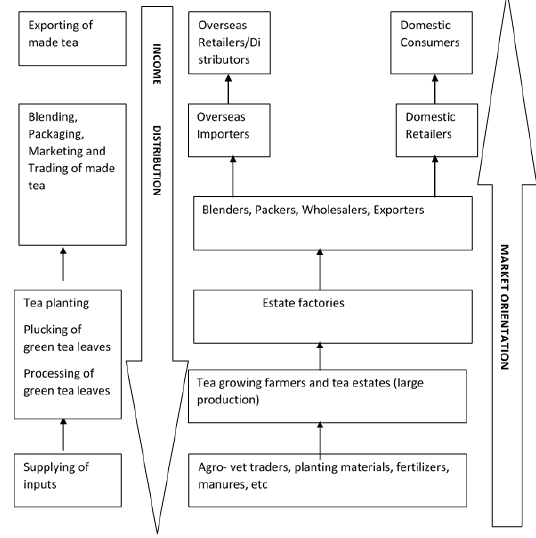
Figure 4: Value chain map of orthodox tea sector